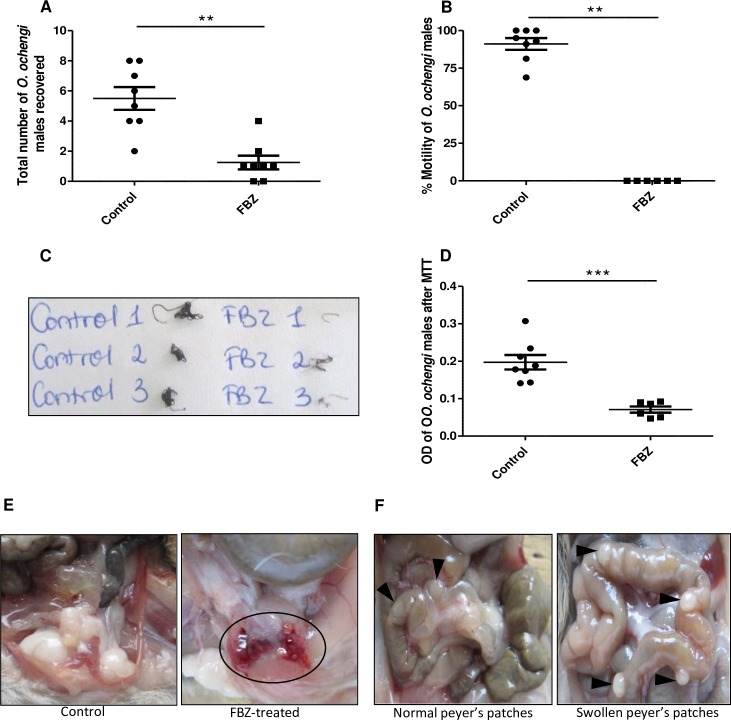
Flubendazole (FBZ) decreases O. ochengi male worm burden and motility in gerbils.Gerbils were implanted with 20 O. ochengi male worms and treated for 5 days subcutaneously starting on day 3 post-implantation with 10 mg/kg FBZ, SID. Animals were sacrificed on day 35 post-implantation. A) Total number of male worms recovered, B) Percentage motility of the male worms recovered, C) Photo of O. ochengi male worms from control and FBZ-treated gerbils after MTT staining, D) OD of DMSO treated male worms after MTT staining, E) Blood clot in the lower peritoneal cavity of FBZ-treated animal (circle), and F) Picture of normal and swollen Peyer’s patches (arrow head). Results are representative of five independent experiments. N = 8 per group. Statistical significance was done by Mann Whitney test. **p <0.01; ***p <0.001.